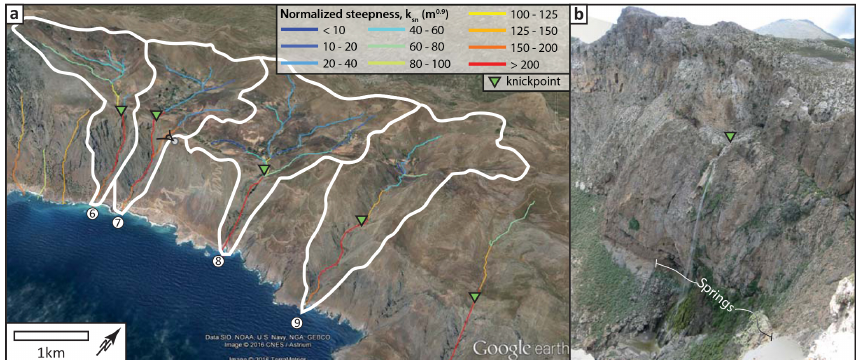
Figure 9. (a) Perspective Google Earth image of basins 6–9 (white outlined polygons) with normalized steepness index ( k sn ) of channels draining areas>0.1km 2 . Channels with k sn >200m 0 . 9 are commonly associated with vertical waterfall reaches. (b) Photograph of vertical waterfall from basin 7. The location of the photo is shown in (a) . Locations of springs are